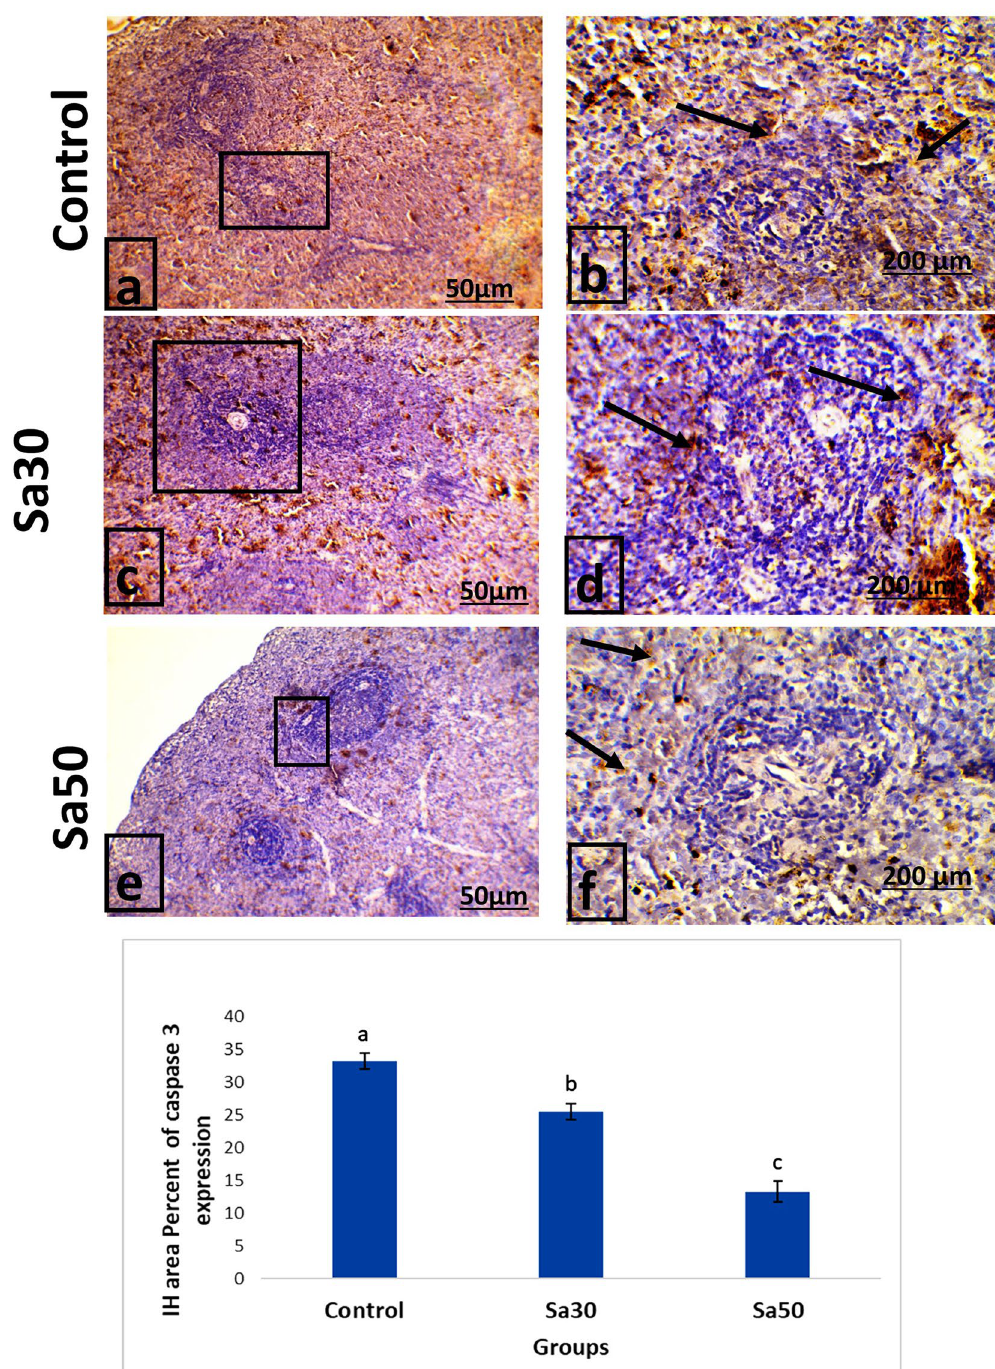
Figure 3. Immunohistochemistry analysis of stained sections of the spleen of rats belonging to the control group and the groups fed Nigella sativa seeds (30 g/kg and 50 g/kg). The percent area of splenocytes showing positive caspase-3 protein expression is shown (arrow, ×10 & ×200 magnification). The mean percentage of positive caspase-3 reactivity is shown in the histogram. Different superscript letters indicate significant differences at P <